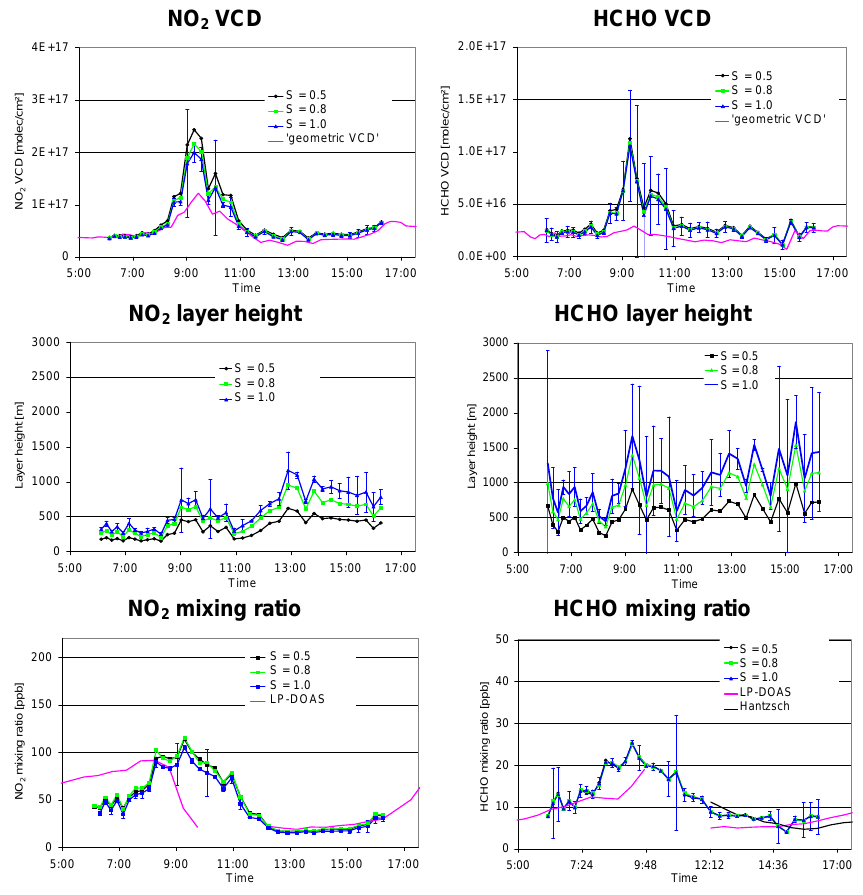
Fig. 8 Diurnal variation of the inversion results for NO 2 (left) and HCHO (right) for the southern telescope on 19 September 2003. In the top panel the trace gas VCDs, in the center panel the layer heights, and in the bottom panel the trace gas mixing ratios are shown. For comparison, also ‘geometric’ VCDs (see Eq. 17) and trace gas mixing rations obtained by independent measurements (LP-DOAS and Hantzsch) are shown. Error bars (for a 95% confidence interval) are determined from the inversion procedure; they are exemplarily shown for the retrieval assuming a box profile (S = 1.0).